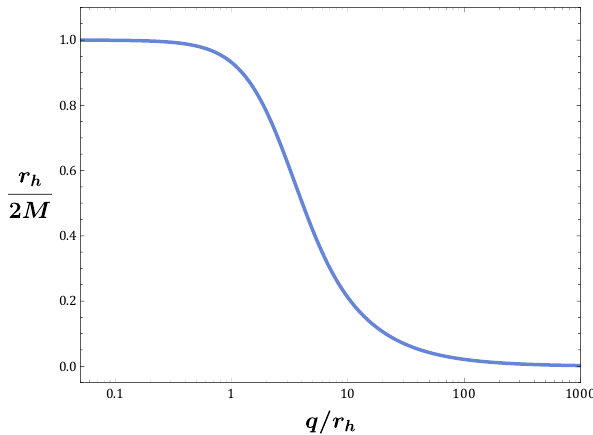
Figure 2. The graph of the fraction r h / (2 M ) in terms of q/r h . Both quantities are dimensionless, while the horizontal axis is